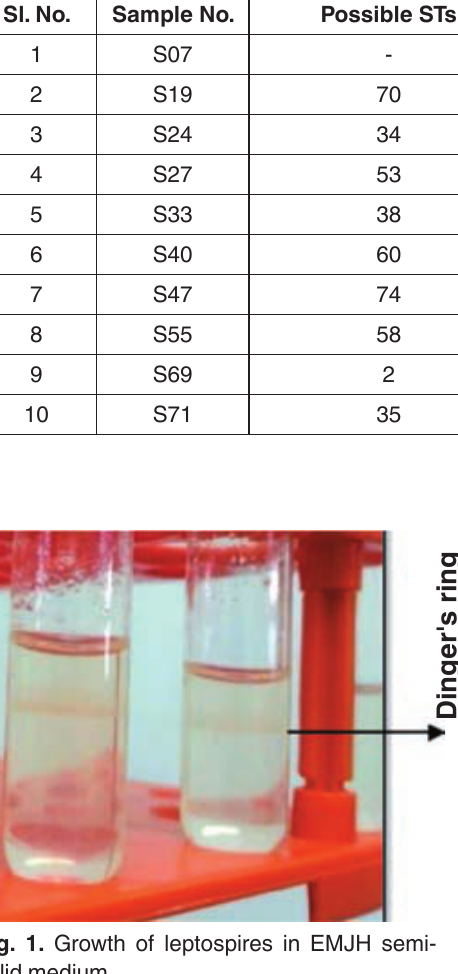
table 3. MLST results sl. No.